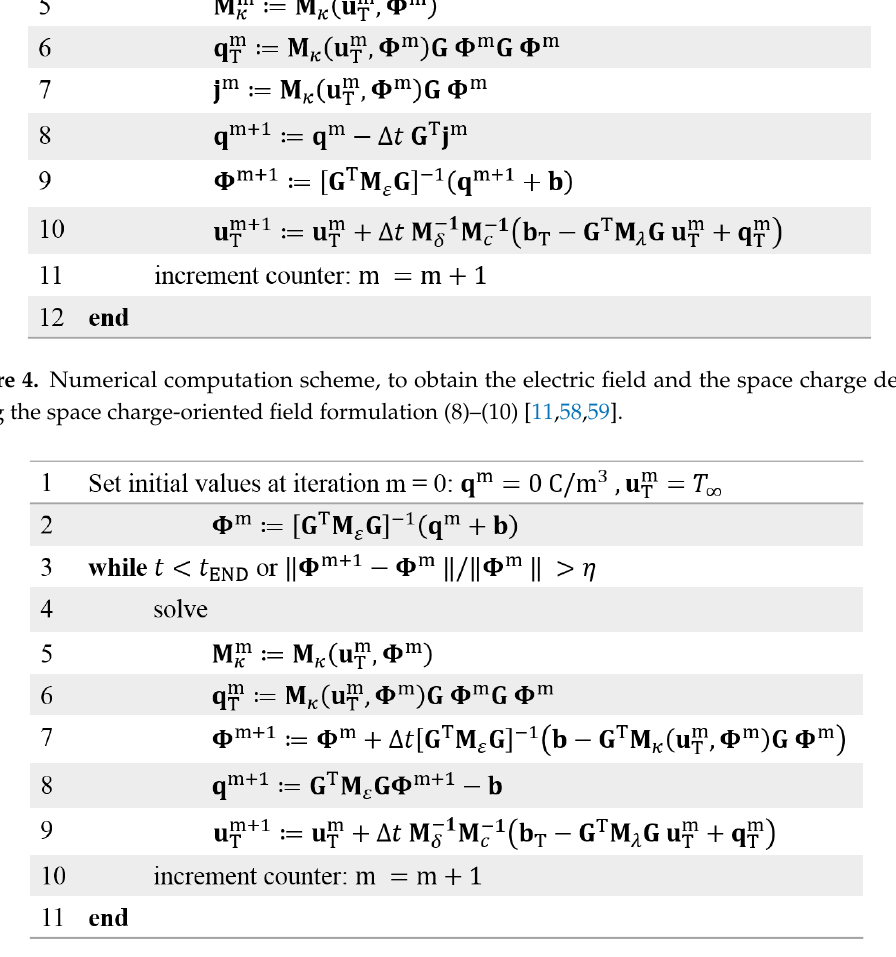
Figure 5. Numerical computation scheme, to obtain the electric field and the space charge density, using the scalar potential field formulation (11) [11,58,59].